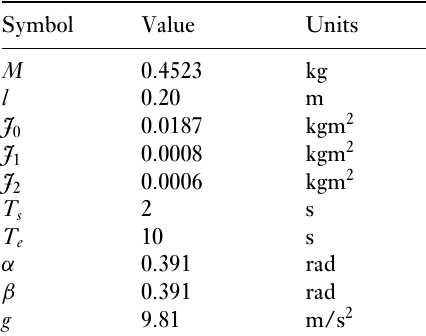
Figure 6 Preliminary experimental prototype. Table 4 Biped (real) robot parameters (left) and feedback gains (right)